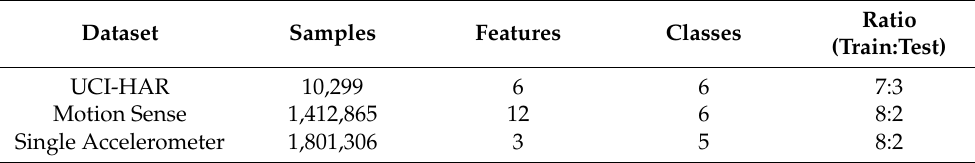
Table 2. Summary of three